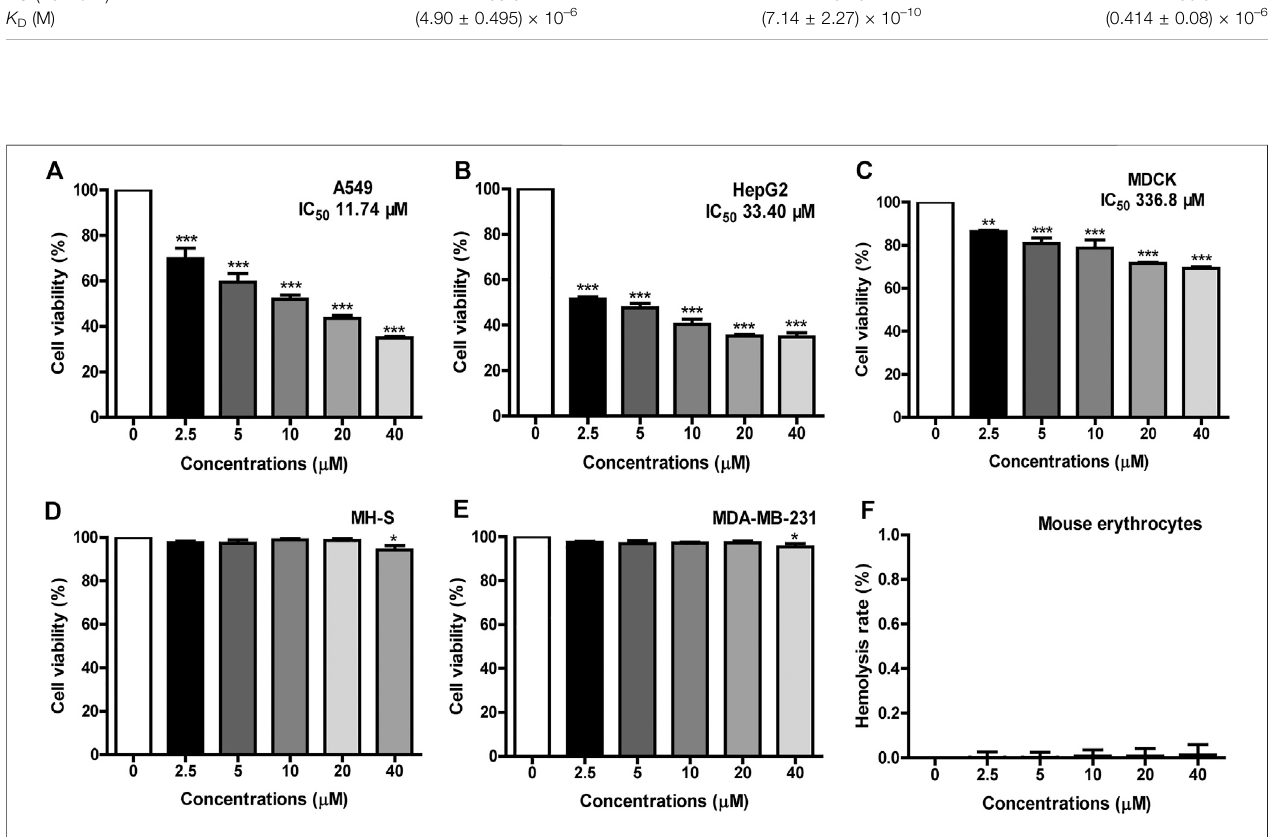
Frontiers in Pharmacology |